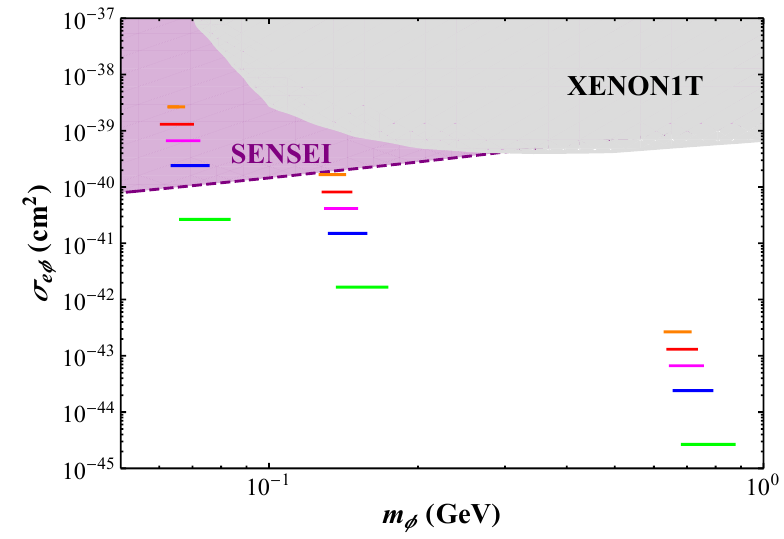
Figure 10. The direct detection cross sections σ eφ (given in eq. (5.1), assuming b = 1 for various selections of m A and g D . Because this cross section is independent of the DM mass D m φ , each benchmark point takes the form of a horizontal line in m φ σ eφ space, with the length − determined by the range of m φ for which the observed relic density can be recreated for some value of r h m h /m A . The lines form 3 groups, which assume m A = 100 MeV (Left), m A = 200 MeV D D D D ≡ (Center), and m A = 1 GeV (Right). Each line in a group assumes g D = 0 . 1 (Green), g D = 0 . 3 D (Blue), g D = 0 . 5 (Magenta), g D = 0 . 7 (Red), and g D = 1 (Orange). The current 90% CL constraint on this cross section from XENON1T ionization data [33] is depicted as a gray shaded region, notably, it does not exclude any of our benchmarks. The projected sensitivity of a 100g yrs SENSEI · null result [6] is depicted as a purple